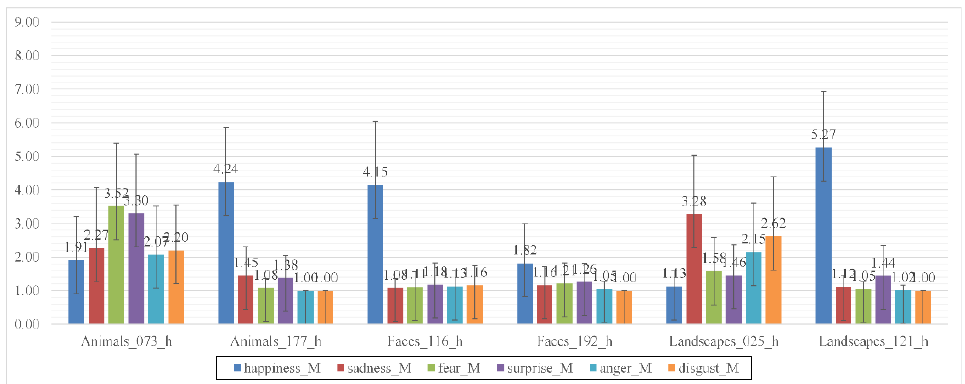
Figure 4. Mean and standard deviations values ( happiness _ M , sadness _ M , fear _ M , surprise _ M , anger _ M , disgust _ M , happiness _ SD , sadness _ SD , fear _ SD , surprise _ SD , anger _ SD , disgust _ SD ) from NAPS BE database representing discrete emotions of 6 pictures used in the experiment. The pictures are illustrated in Figure 3.